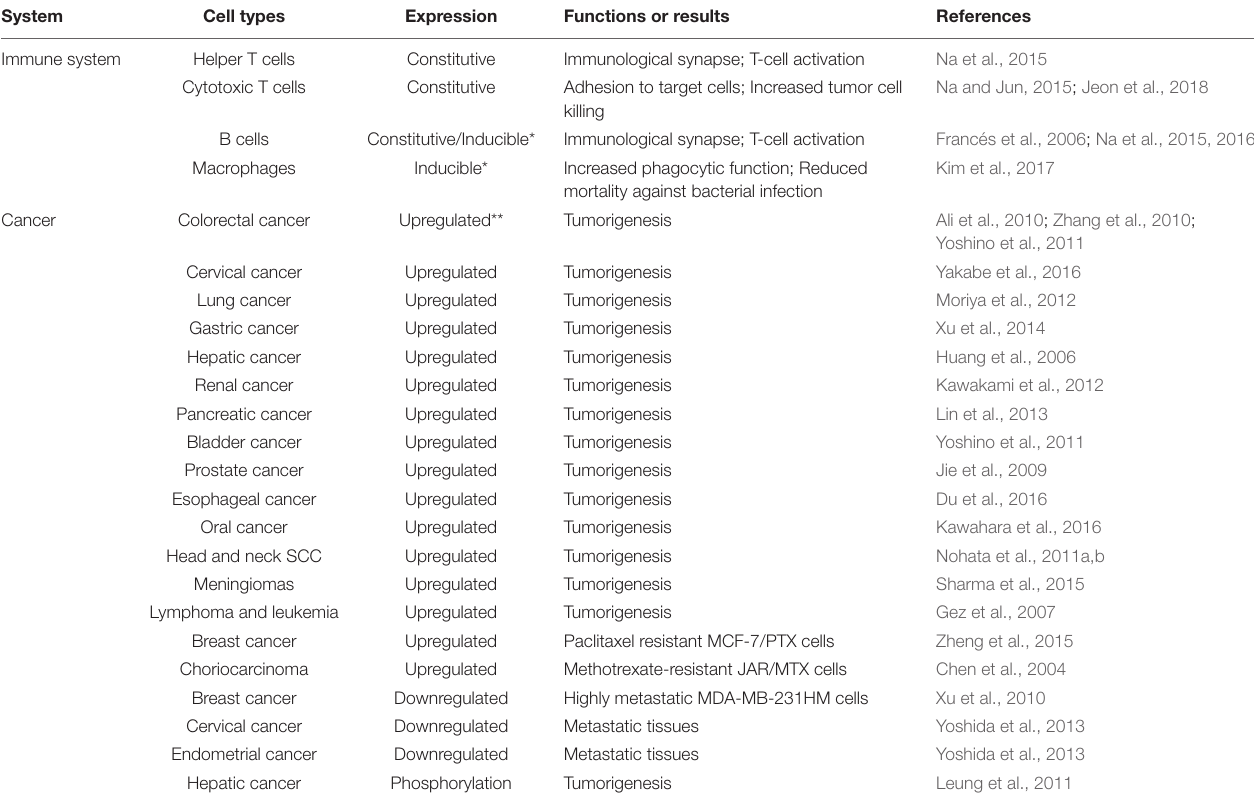
TABLE 1 | Known and putative functions of transgelin-2 in immune and cancer